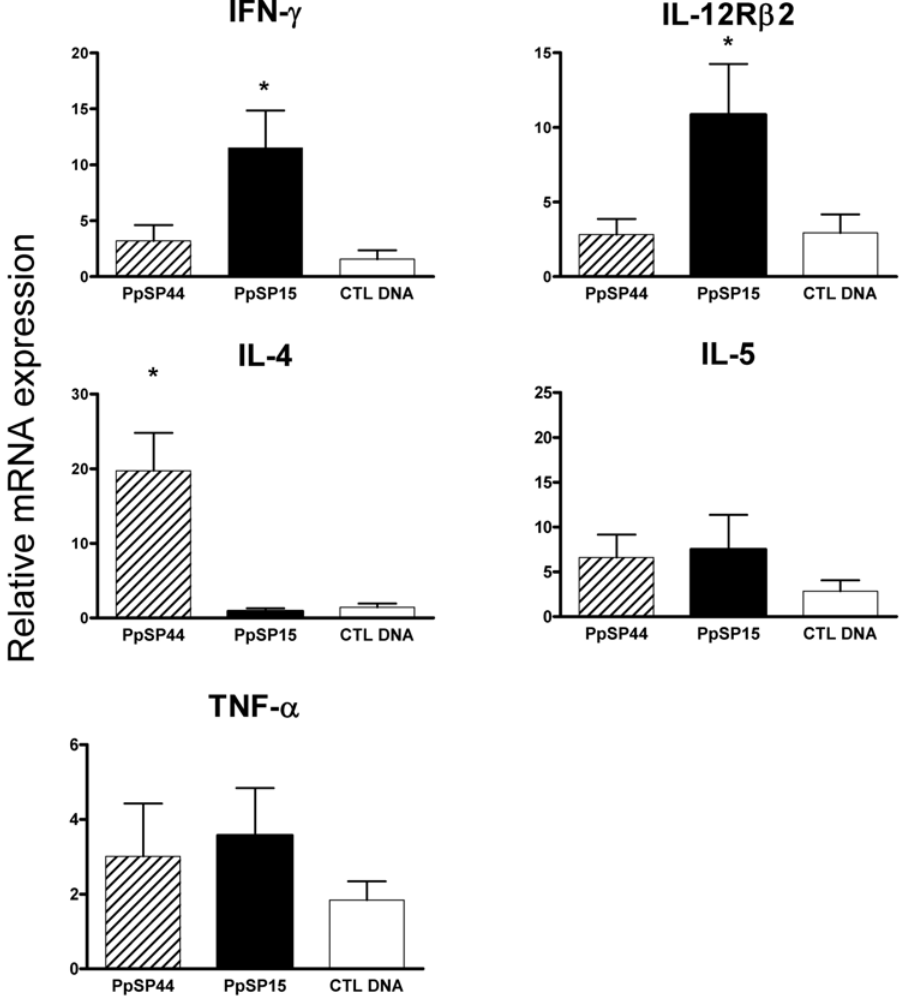
Figure 5. Early expression of cytokines after challenge with SGH-LM in CTL DNA, PpSP15- or PpSP44-immunized mice. Two hours after challenge with 500 L. major metacyclics and 0.5 pairs of SGH, expression of IFN- c and IL-12R b 2 was induced in mice immunized with PpSP15. In contrast, mice immunized with PpSP44 induced the expression of IL-4. Relative mRNA expression was determined by real time PCR and normalized to the18S housekeeping gene. Values represent the fold increase over naı¨ve mice after challenge with SGH-LM. Bars represent the mean 6 the SEM for 24 mice per group. Asterisks indicate statistical significance ( p , 0.05) between the PpSP15 and the PpSP44 experimental groups. Data represent the combined outcome of three independent